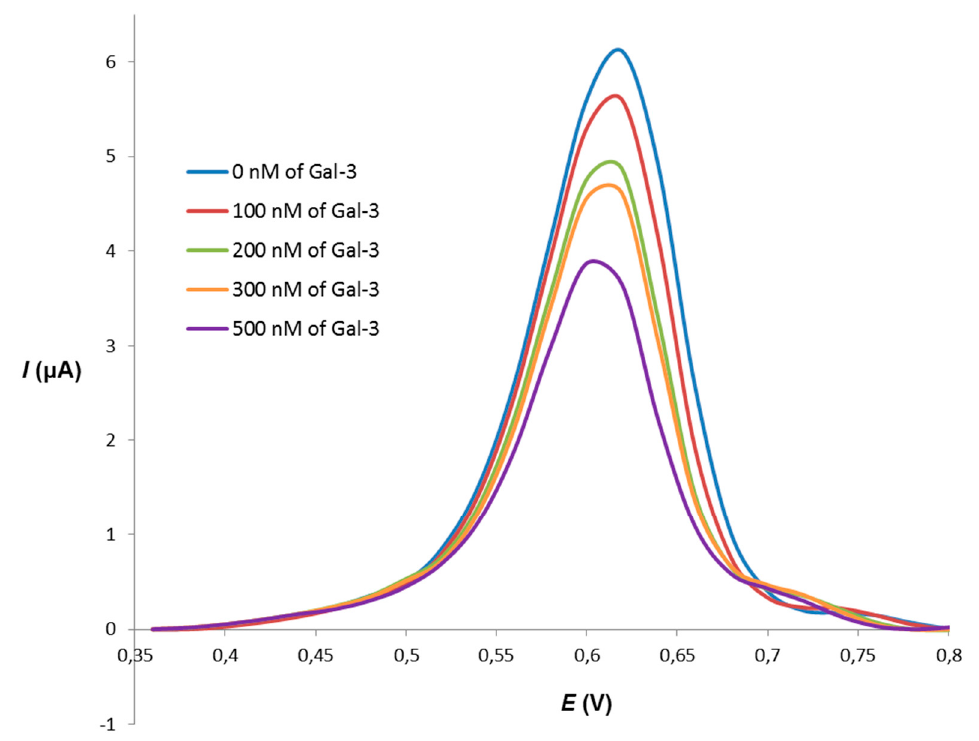
Figure 8. Di ff erential pulse voltammogram for AuNP@Fc-Lac-modified glassy carbon electrode in the presence of increasing amounts of Gal-3 (0 nM, blue; 100 nM, red; 200 nM, green; 300 nM, orange; 500 nM, purple) in 10 mM phosphate bu ff er at pH 7.2 with 20 mM NaCl as the supporting electrolyte.